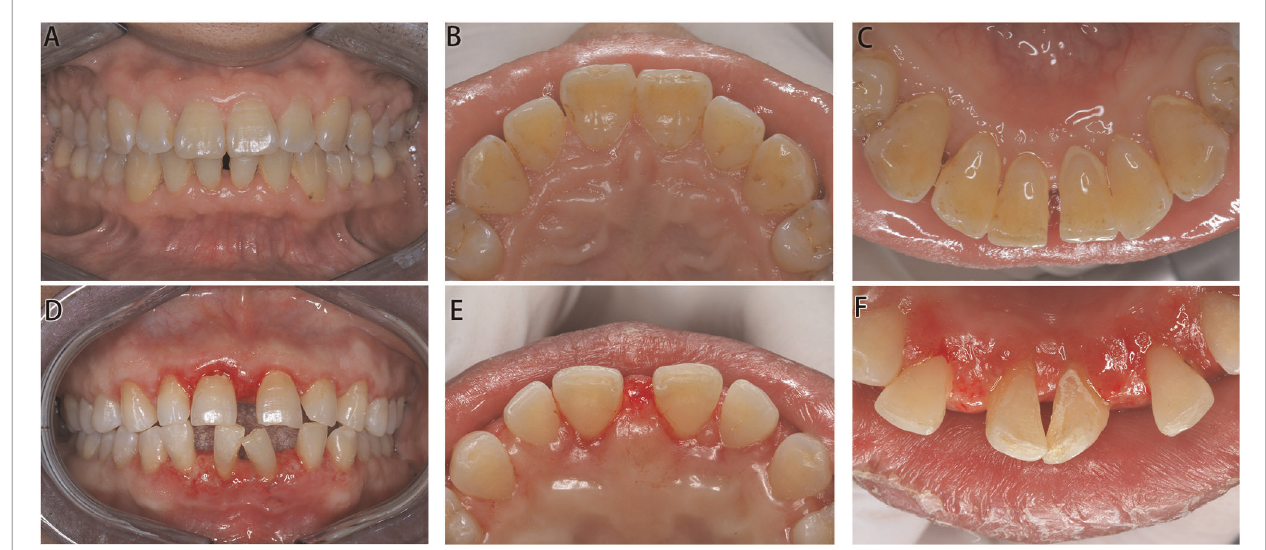
FIGURE 3 | Intraoral images of Cases 1 and 2 post operation. ( A – C ) Images of Case 1 in 1 year post operation. ( D – E ) Images of Case 2 in 1 week post